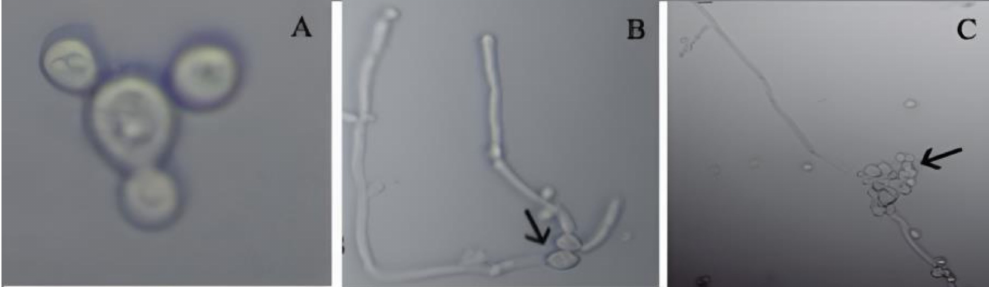
Figure 2. Various morphological forms of C. albicans at 100 × magnification: ( A ) Budding, ( B ) Chlamydospores, ( C ) Blastospore. ( B , C ) Incubated in horse serum for 8 and 24 h,